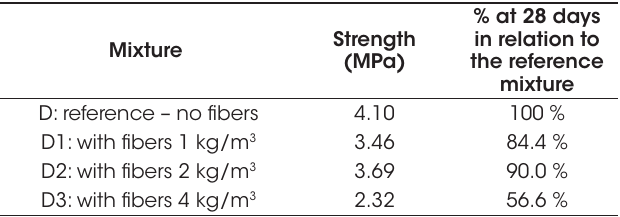
Axial compression strength after the addition